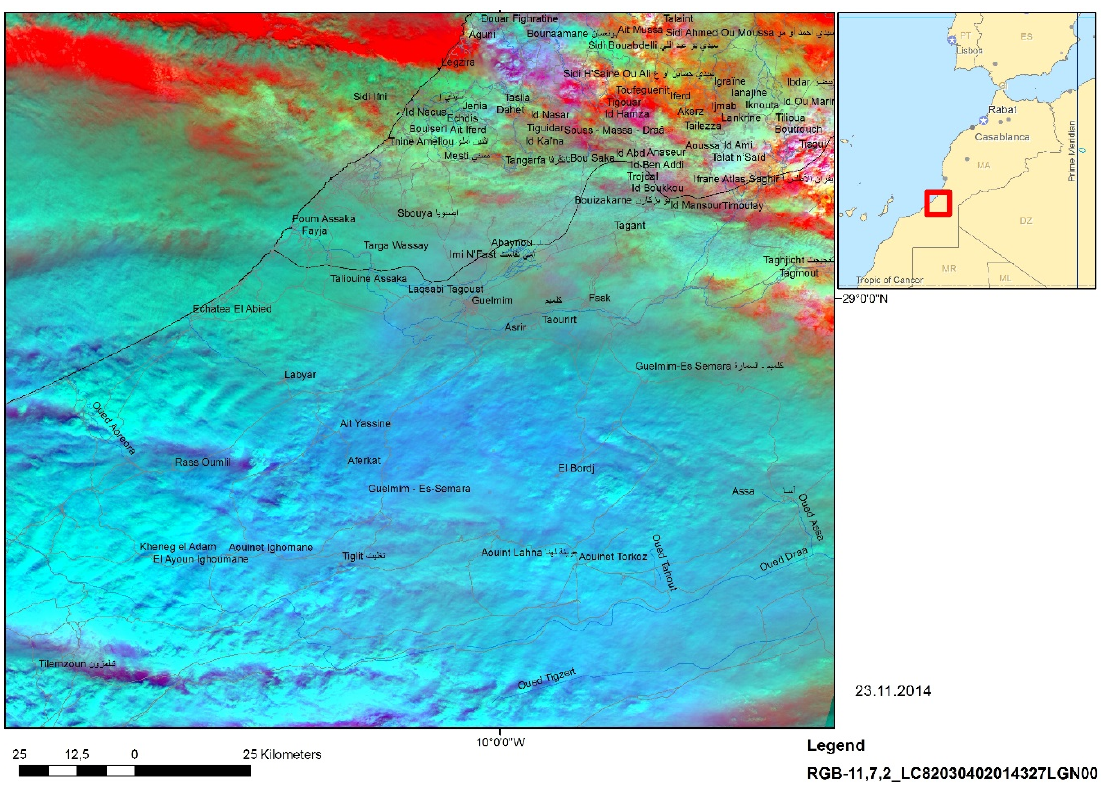
Figure 1. Cloud cover visible on a Landsat 8 scene of the Guelmim area related to heavy rainfall on 23 November